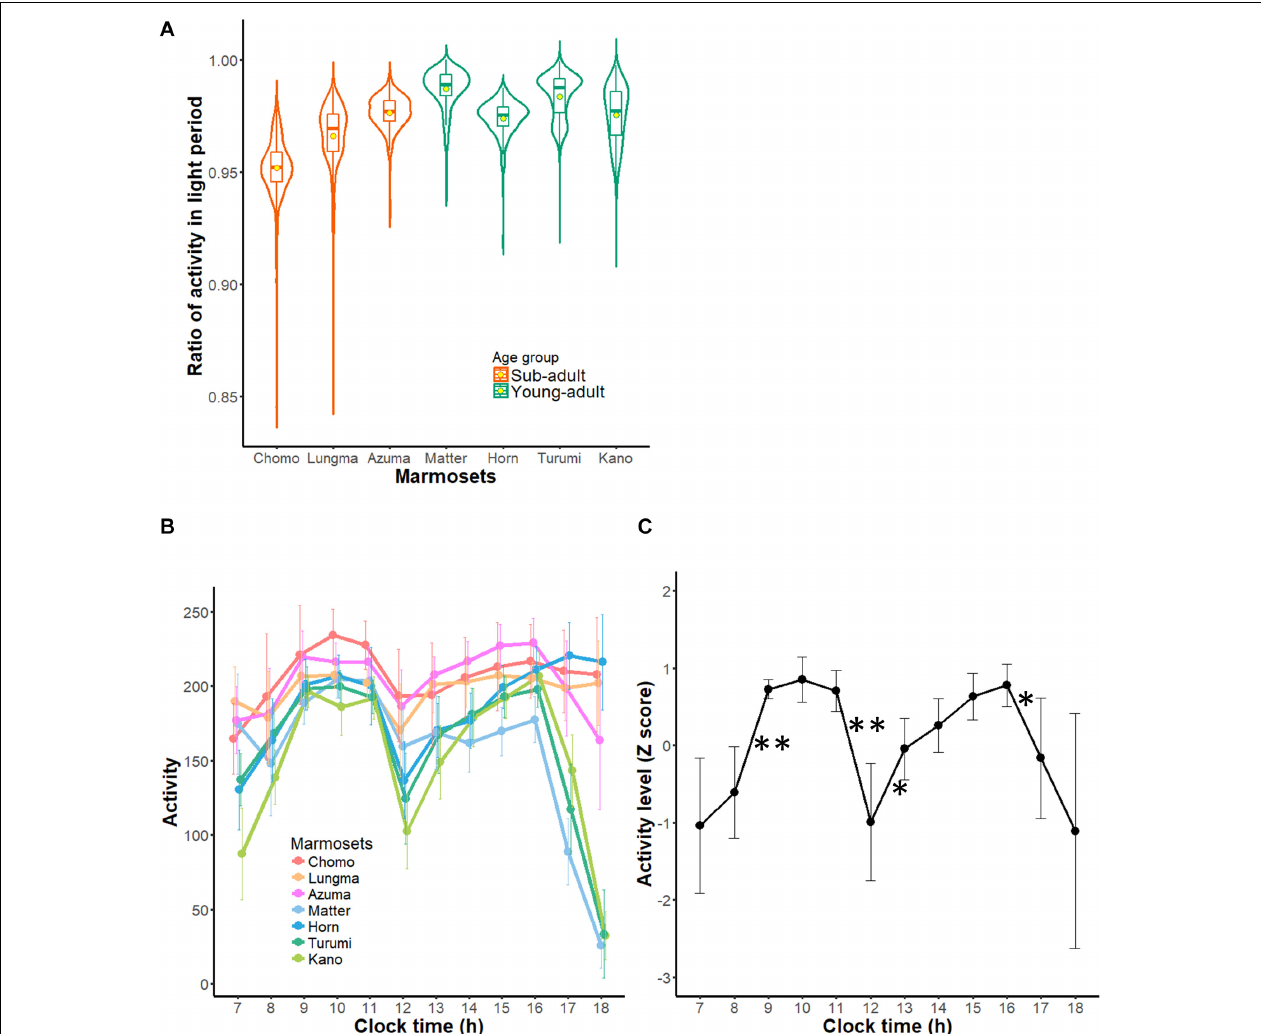
FIGURE 4 | Diurnal activity pattern of common marmosets. (A) Diurnal index of each marmoset during all recording periods is represented in the form of a violin plot. Contour indicates the histogram for indexes during all recording periods and the box plot within each contour indicates the medians (horizontal bars) and means (circles). (B) Hourly activity of each marmoset during daytime (mean ± SD). Each color represents each marmoset (warm colors for sub-adult groups and cold colors for young adult group are used to match those of other figures). (C) A collective profile of daytime activity of marmosets. This plot shows mean ± SD of all seven marmosets from each marmoset’s Z-scored profile. ∗∗ 1% significant difference from the next hour, *5% significant difference from the next hour.